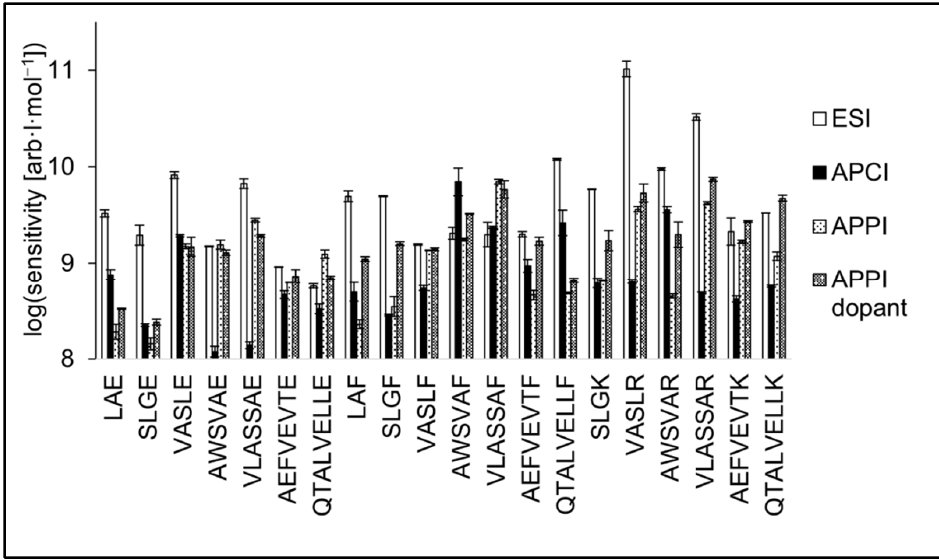
Figure 7. Sensitivities of peptide standards shown in positive logarithmic scale for ESI, APCI, APPI, and dopant APPI. Data were obtained by FIA using methanol/water (80:20 v/v) mobile phase, flow rate 400 μ L·min − 1 . The error bars represent the standard errors of the mean.